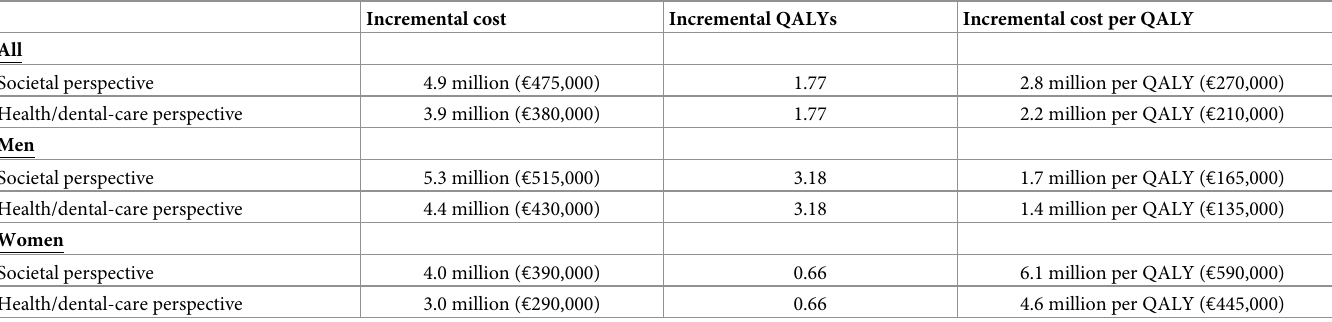
Table 3. Long-term costs and health outcomes for a cohort of 2,025 individuals. Costs expressed in Swedish kronor, SEK (Euros in